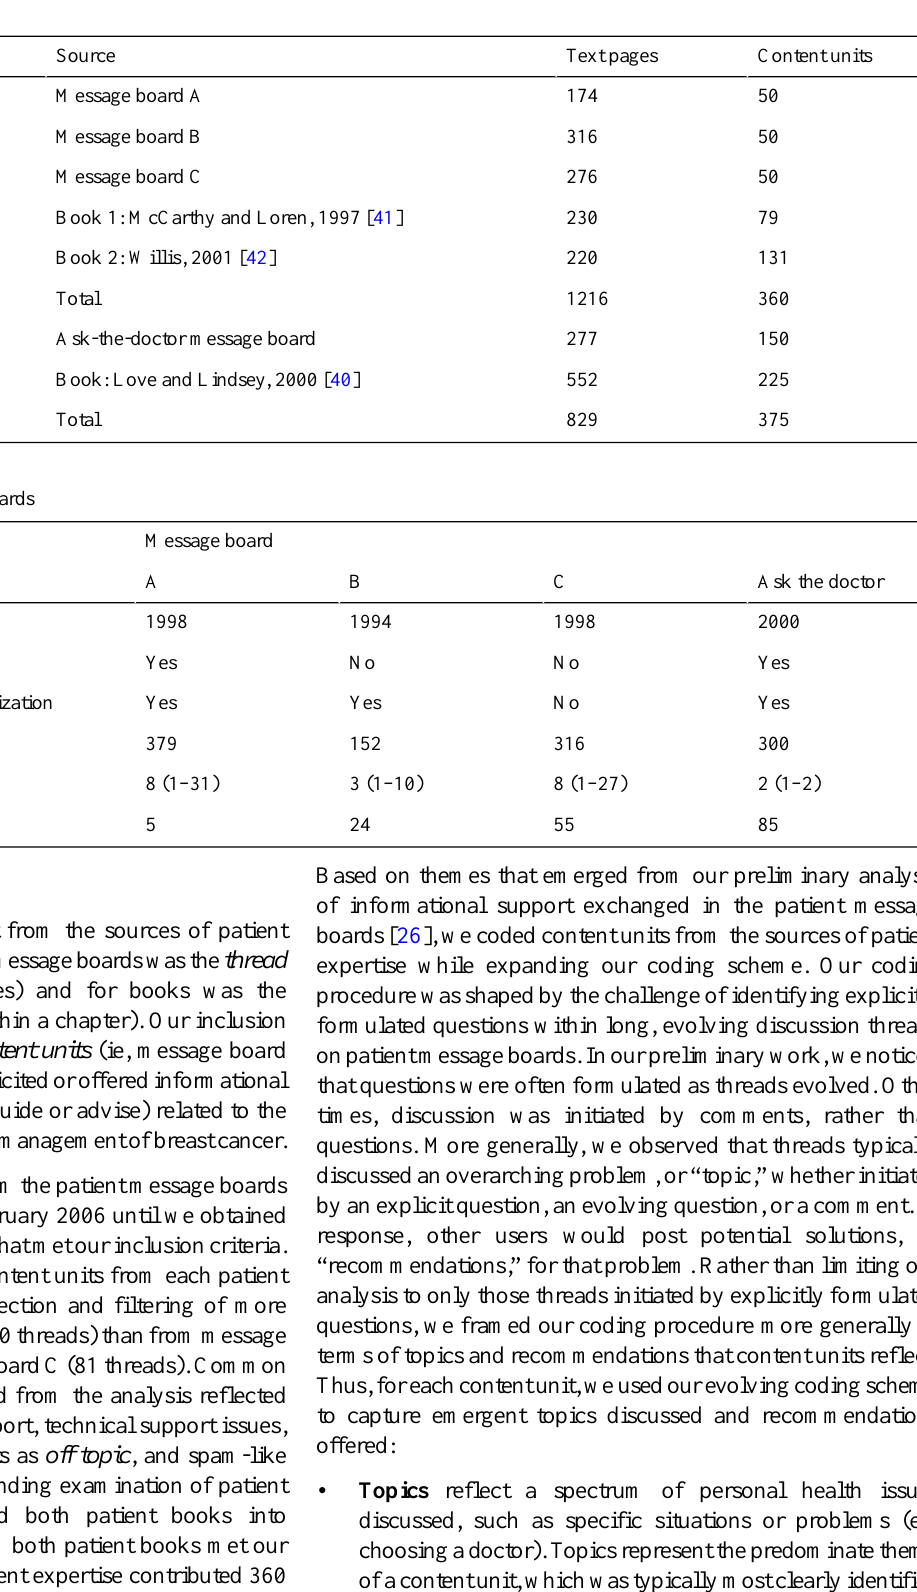
Table 1. Content sources